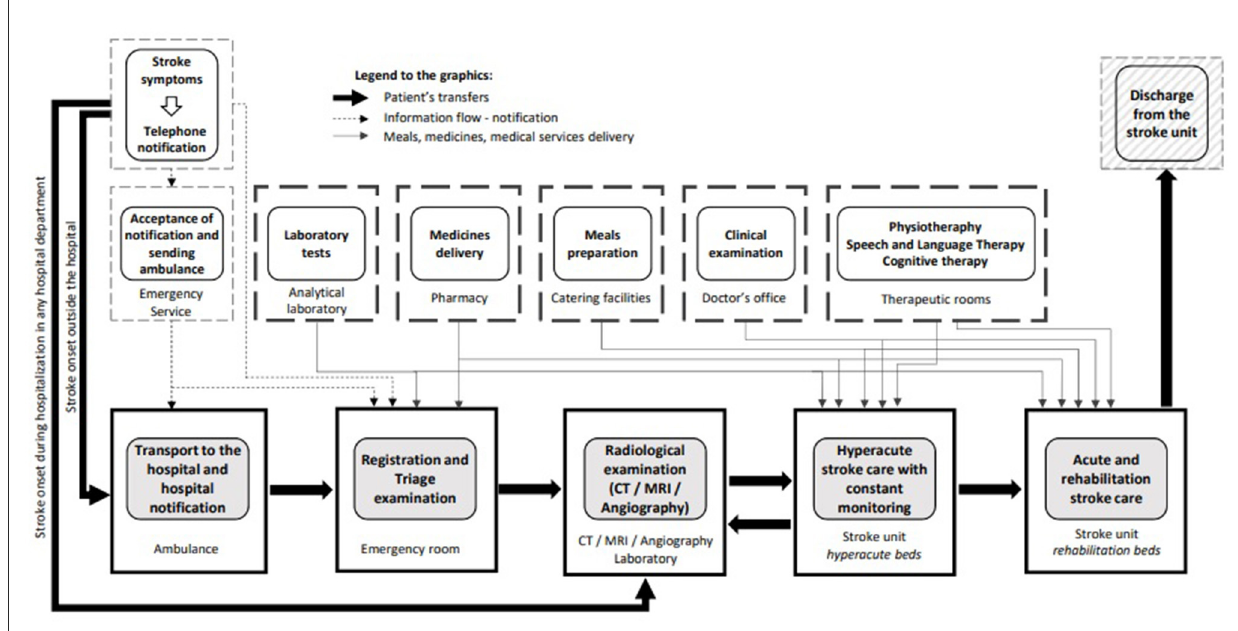
FIGURE1 In-hospital acute stroke care pathway (unpublished - drawn by Jarosław Ge˛bski, Polish Society of Health Economics, Warsaw, Poland).